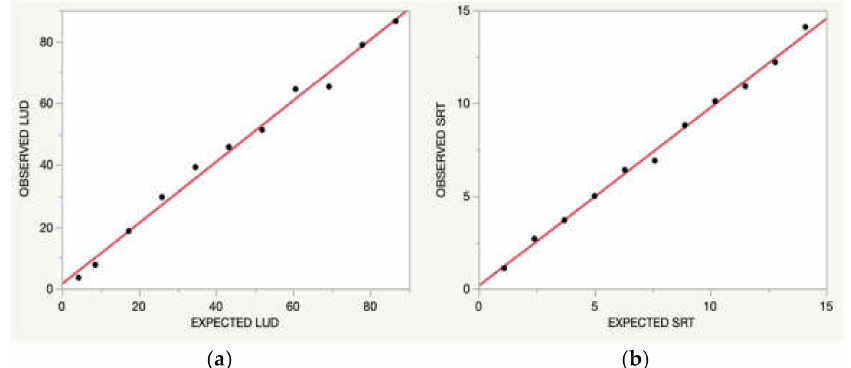
Figure 1. Comparison between the observed and expected results: ( a ) linearity under dilution (LUD) of the PTH concentration in a pool of sera serially diluted with saline solution; ( b ) spike recovery test (SRT) of the PTH concentration in a pool of sera with a low PTH concentration spiked with increasing amounts of a serum with a medium PTH concentration. The solid line indicates the linear association between the expected and observed results.